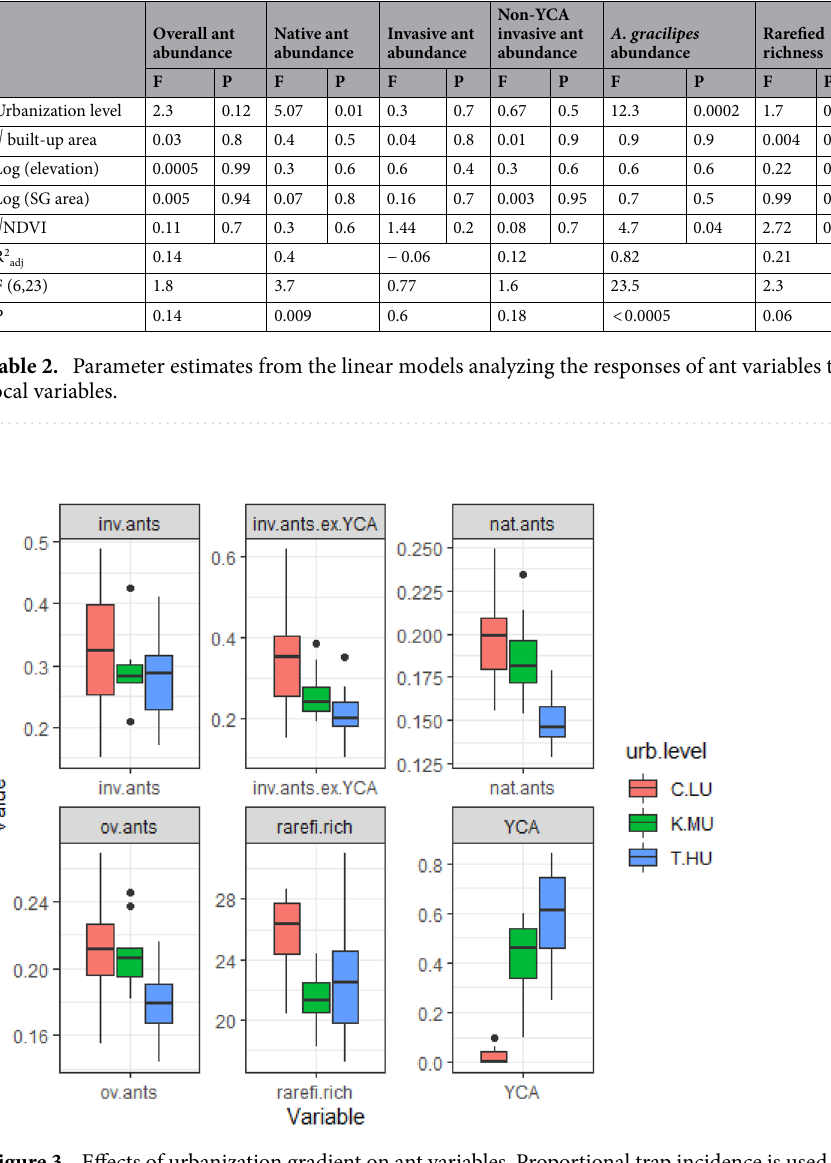
Figure 3. Effects of urbanization gradient on ant variables. Proportional trap incidence is used as the measure of abundance. inv.ants = overall invasive ants; inv.ants.ex.YCA = non- A. gracilipes invasive ants; nat.ants = native ants; ov.ants = overall ants; rarefi.rich = Richness of native ants; YCA = abundance of Yellow-Crazy Ant ( A. gracilipes ). Urbanization levels: C.LU = less-urbanized Kodagu; K.MU = moderately-urbanized Kasaragod; T-HU = Highly-urbanized